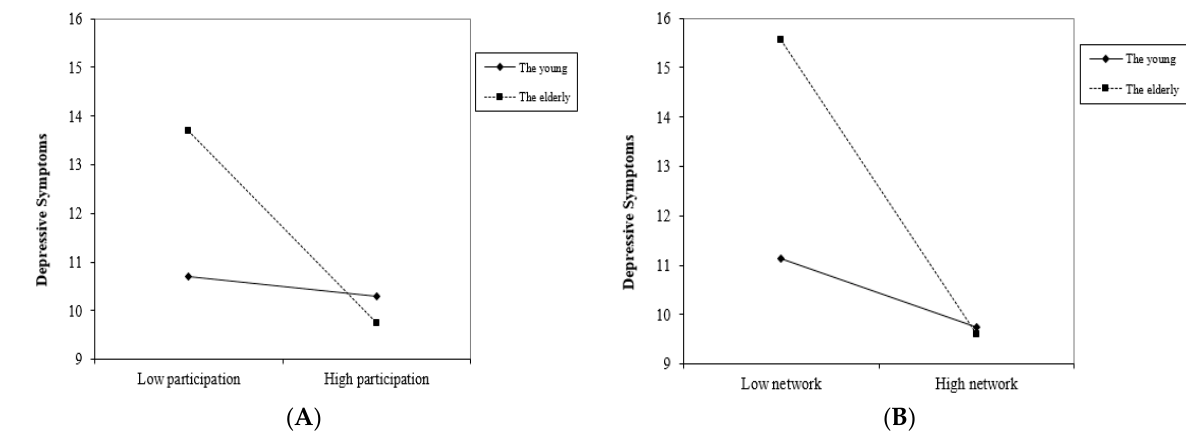
Figure 1. The relationship between NSC and depressive symptoms varied among age groups. ( A ) refers to the relationship between social participation and derpessive symptoms among age groups; ( B ) refers to the relationship between discussion network and depressive symptoms among age groups.